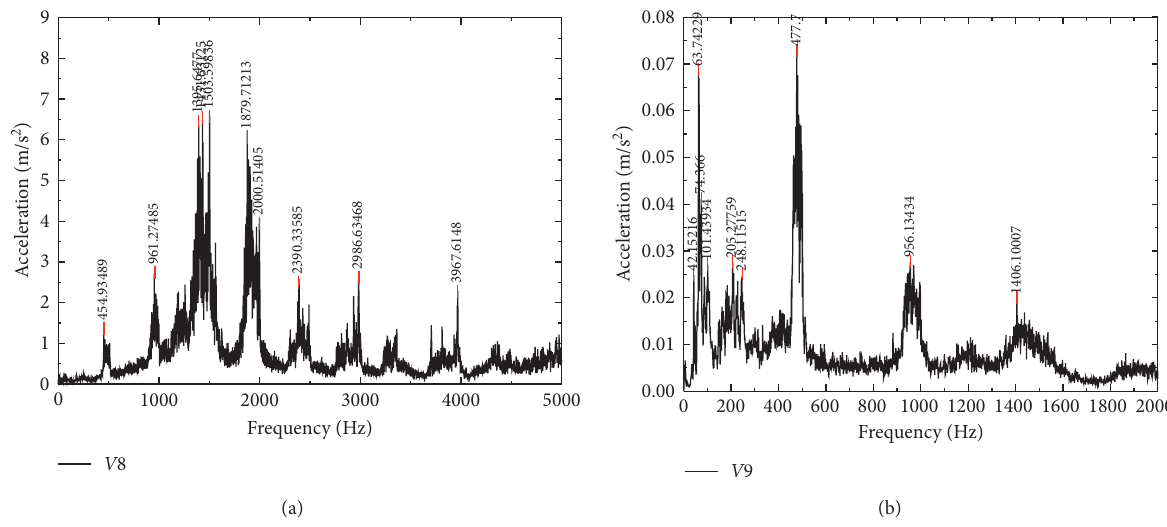
Figure 6: Vibration spectra of the (a) rail and (b) top board of the box girder.